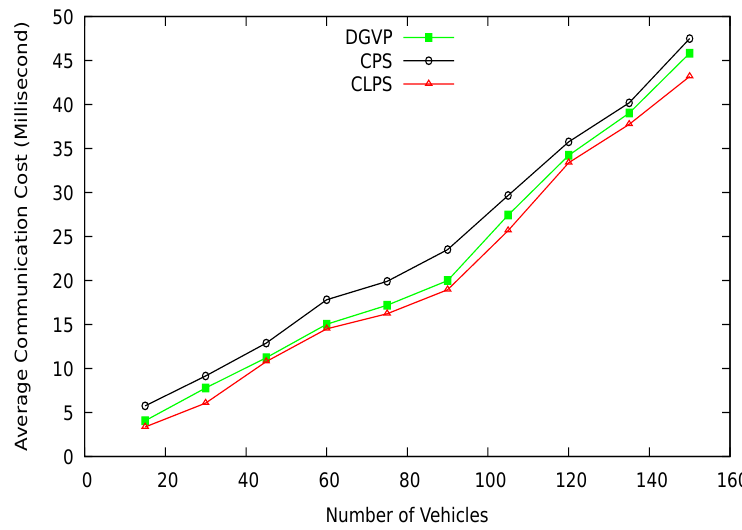
Figure 27. Communication latency at a different number of